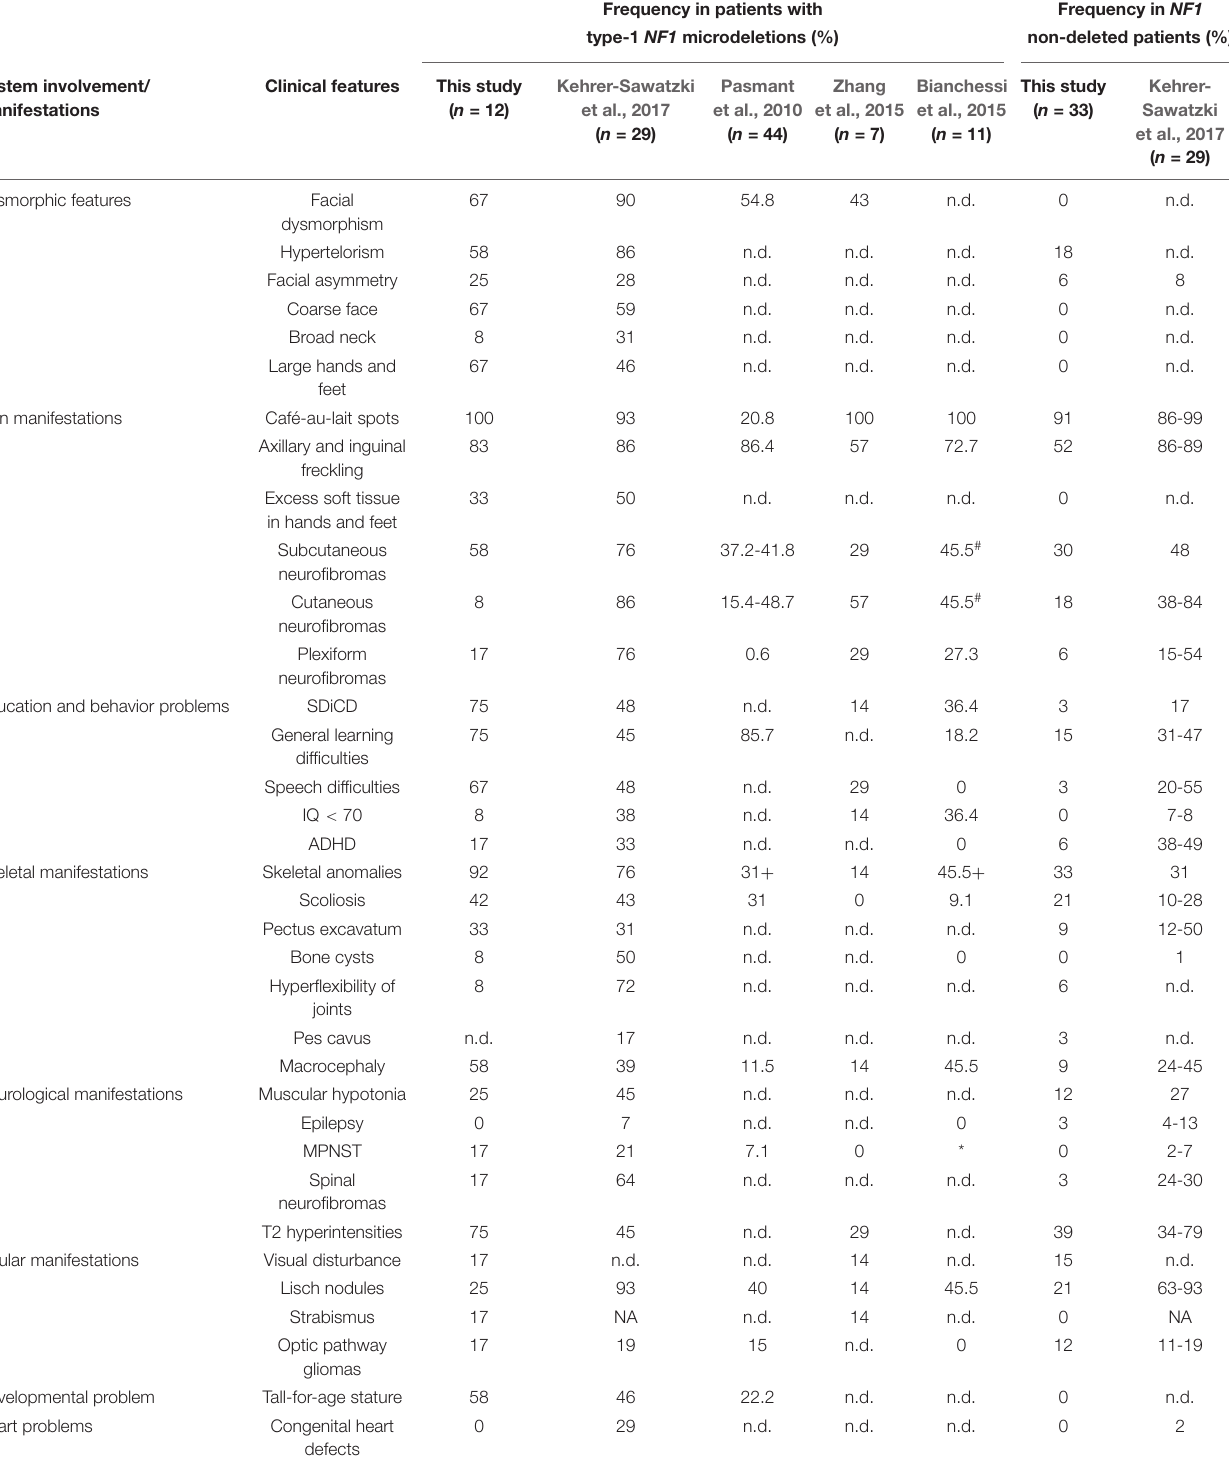
TABLE 2 | Clinical features of patients with type-1 NF1